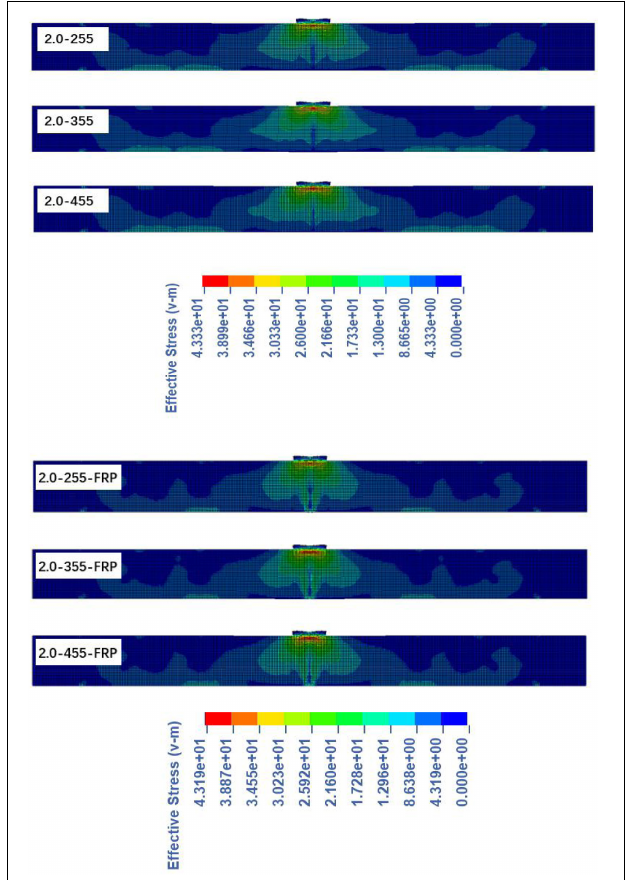
FIGURE 16 | Equivalent Stress field under different weights.